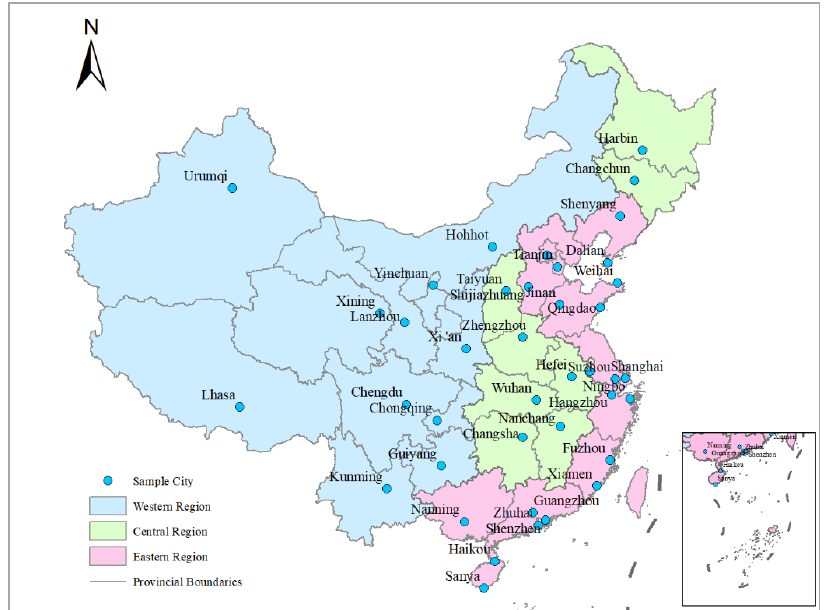
Figure 2. Research area. These maps were drawn according to the standard map with the drawing No. GS (2019) 1673, which was downloaded from the standard map service website of the Ministry of Natural Re-sources of the People’s Republic of China. No modifications were made on the base map.